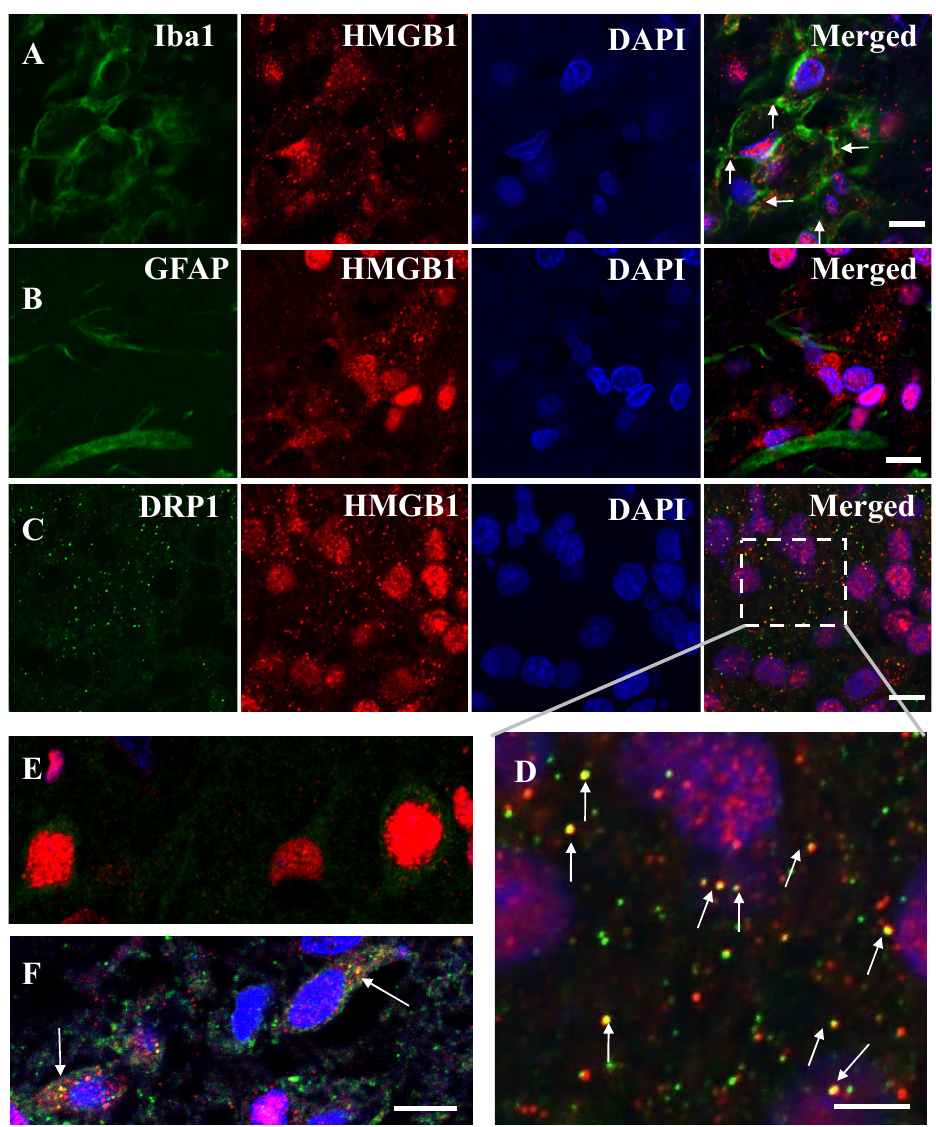
Figure 6. Immunostaining of HMGB1 with Iba1, GFAP, and Drp1. ( A ) Iba1 and HMGB1 staining at 10 days post-MCAO. ( B ) GFAP and HMGB1 staining at 10 days post-MCAO. ( C ) Drp1 and HMGB1 staining at 10 days post-MCAO. Scale bar: 10 μ m. ( D ) Enlarged image of the boxed area in (C). Scale bar: 5 μ m. ( E ) Drp1 and HMGB1 staining in the cortex of control brain (sham group). ( F ) Drp1 and HMGB1 staining at 12 h after reperfusion of MCAO. White arrows show the colocalization of HMGB1 and Drp1. Scale bar: 10 μ m.